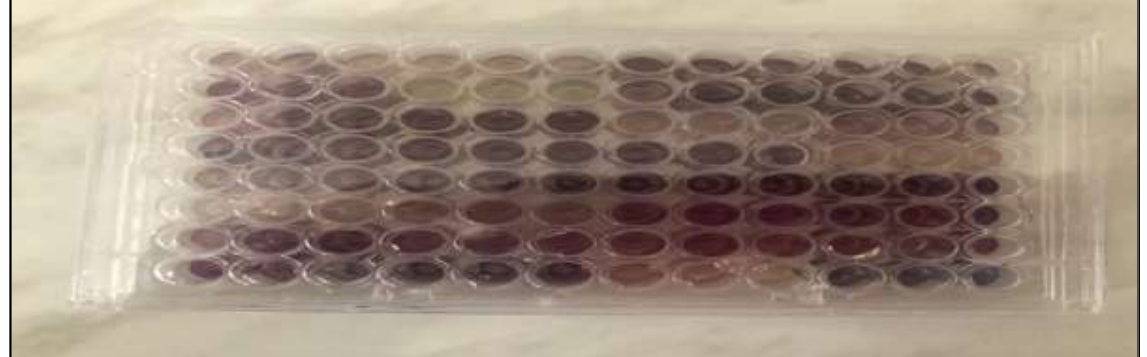
Figure 2. 96 wells plate that is ready for scan with ELISA